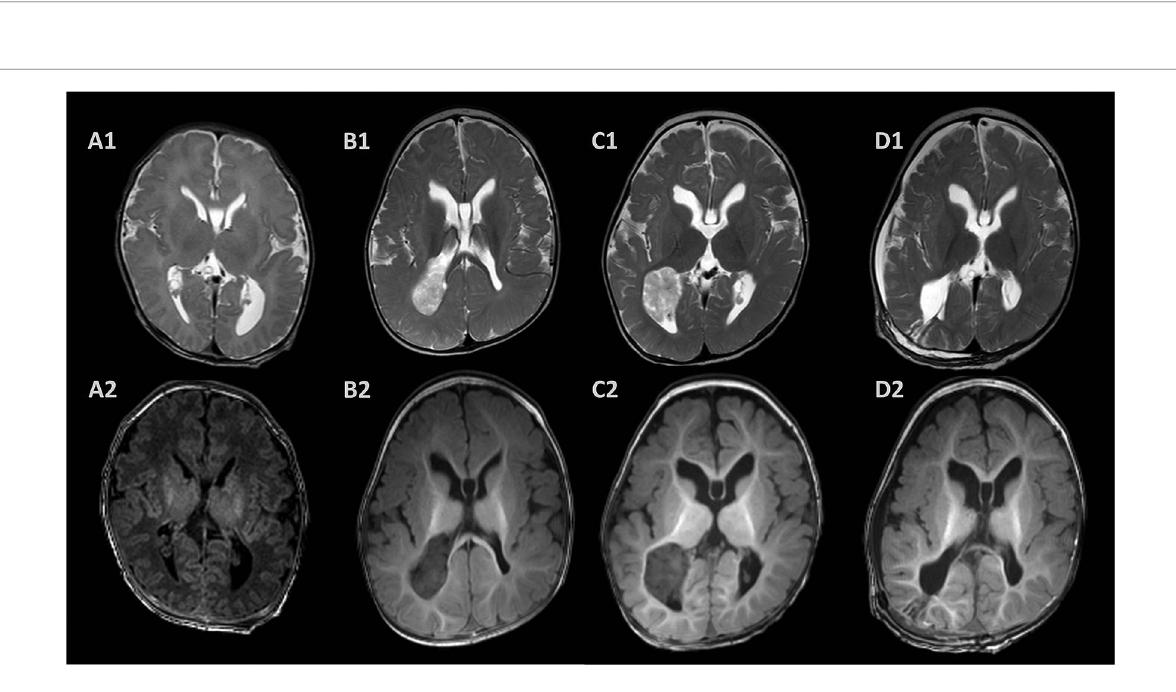
FIGURE 3 Postnatal magnetic resonance images. The brain MRI showed dilated ventricles, corpus callosum agenesis, and subependymal pseudocyst 3 days after birth ( A ). A large mass located in the posterior horn of the right ventricle with T2 heterogeneously hyperintense and T1 hypointense at 6 months ( B ) and 10 months ( C ) after birth with progression. T2- and T1-weighted images showed a Normal appearing choroid plexus and porencephalic cavity 2 weeks after surgery ( D